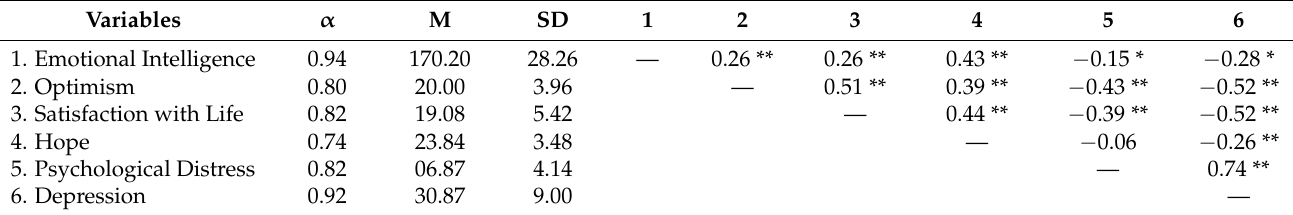
Table 2. Reliability coefficients, means, standard deviations, and correlations (Study